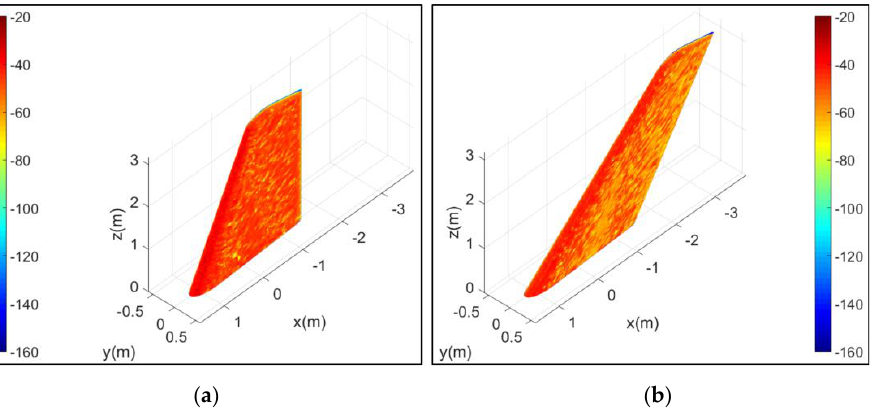
Figure 16. Surface scattering analysis: RCS unit: dBm 2 ; α = 25 °; F rh = 6 GHz; β = 0 ° ; ( a ) Case at X t = 0.3256 m; ( b ) Case at X *.